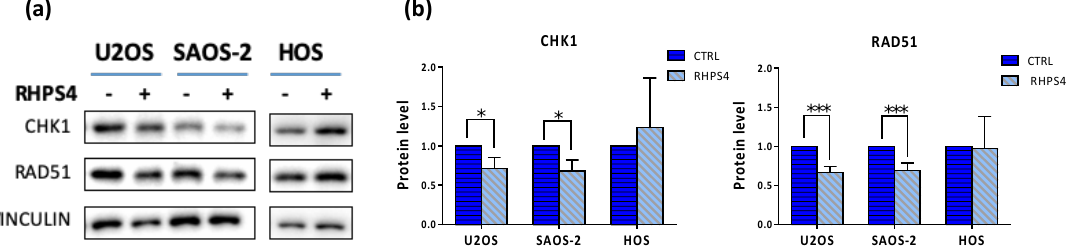
Figure 6. ( a ) Representative image of CHK1 and RAD51 proteins obtained by Western blot analysis. ( b ) Quantitation of protein levels showed a very significant ( p < 0.001) and a significant ( p < 0.05) decrease of RAD51 and CHK1 proteins, respectively in both ALT-positive cell lines. Errors bars denote standard deviations. * p < 0.05, *** p < 0.001 (Student’s t -test).